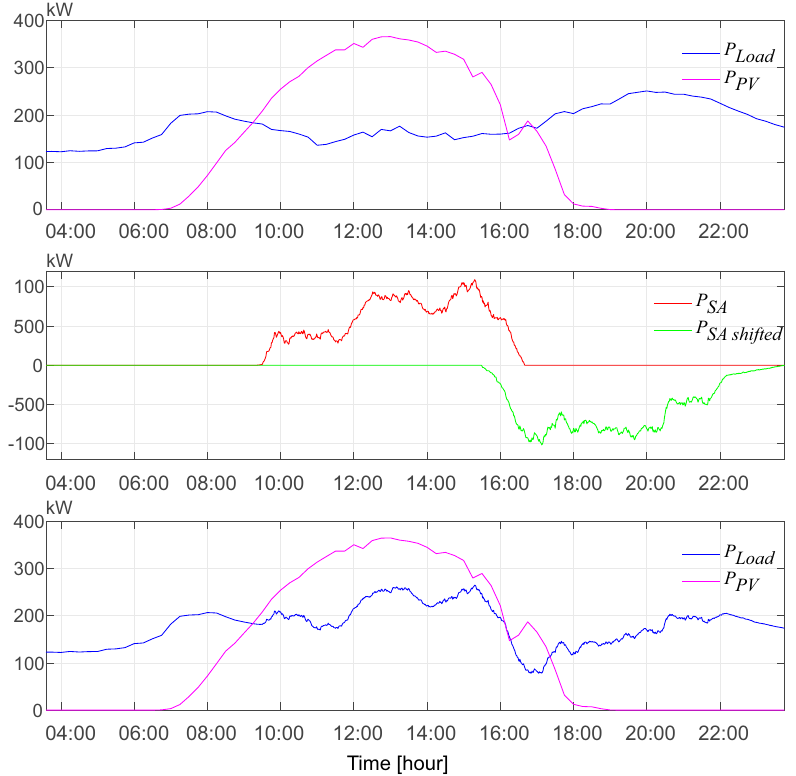
Figure 15. Experimental results: ( top ) load profile and generation profile of PV installations; ( middle ) the power consumed by the SA devices as a result of the proposed EEM algorithm, and an exemplary power profile shifted from the evening hours as a result of not switching on the SA; ( bottom ) load profile after applying the proposed EEM algorithm and PV installation generation